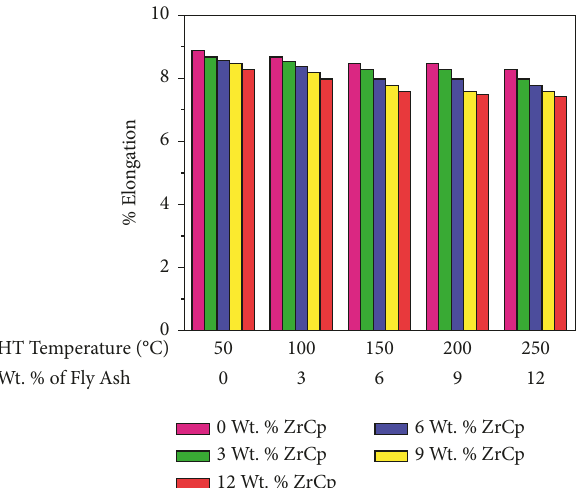
Figure 4: % elongation for different experimental conditions.